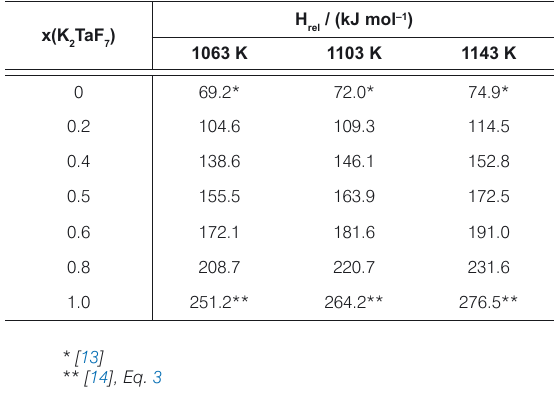
Table 1. Molar relative enthalpy of melts.